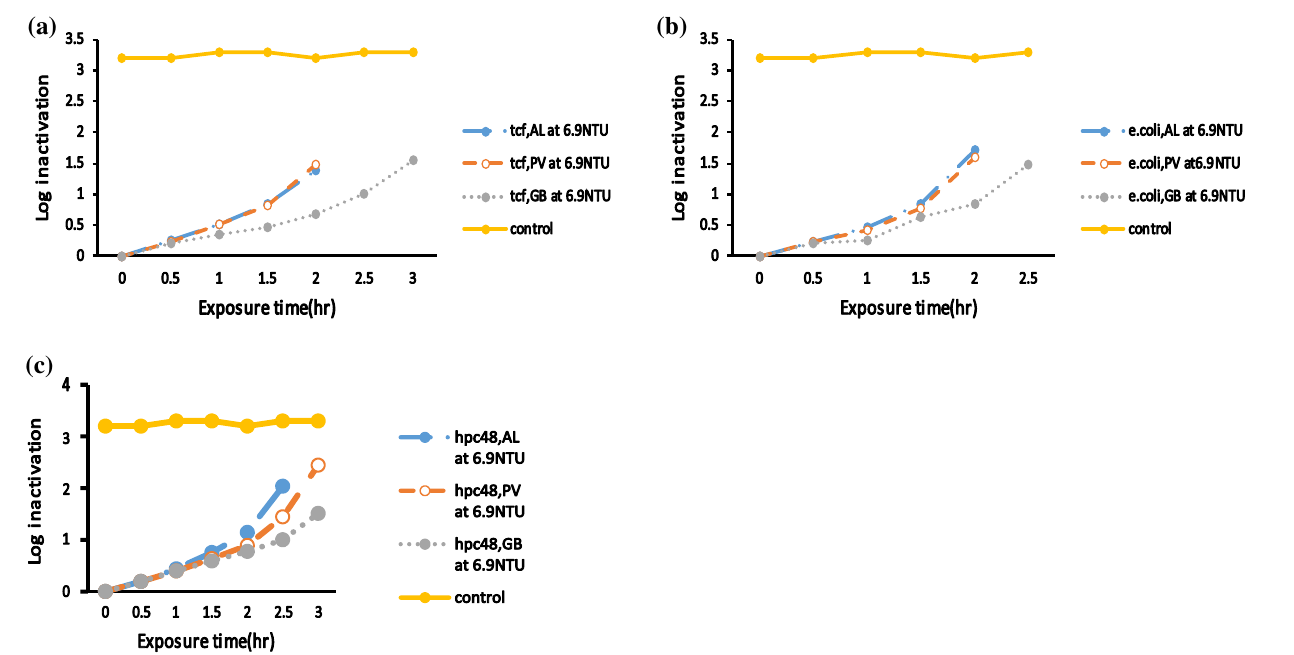
tors for E. coli inactivation. c Comparison between concentrators for